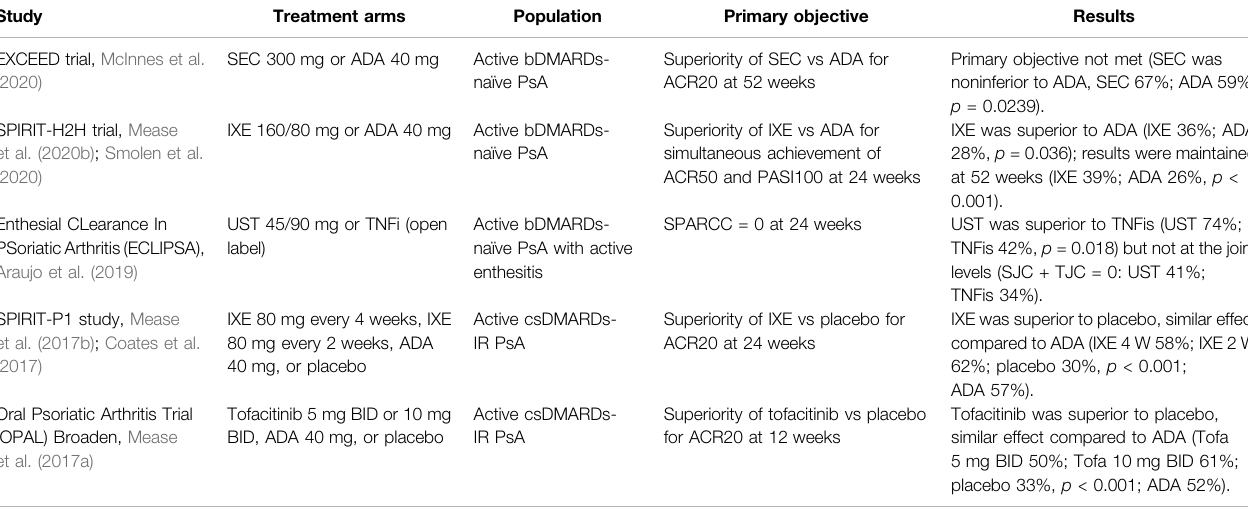
TABLE 2 | Main differences in clinical response between TNFis and non-TNF b/tsDMARDs in PsA phase III RCTs directly comparing the treatment